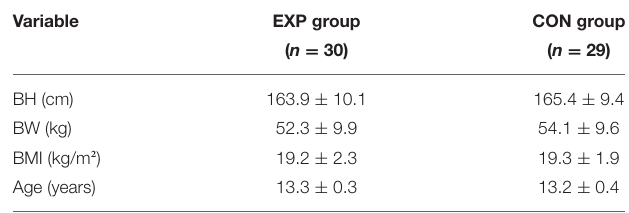
TABLE 1 | General characteristics of the